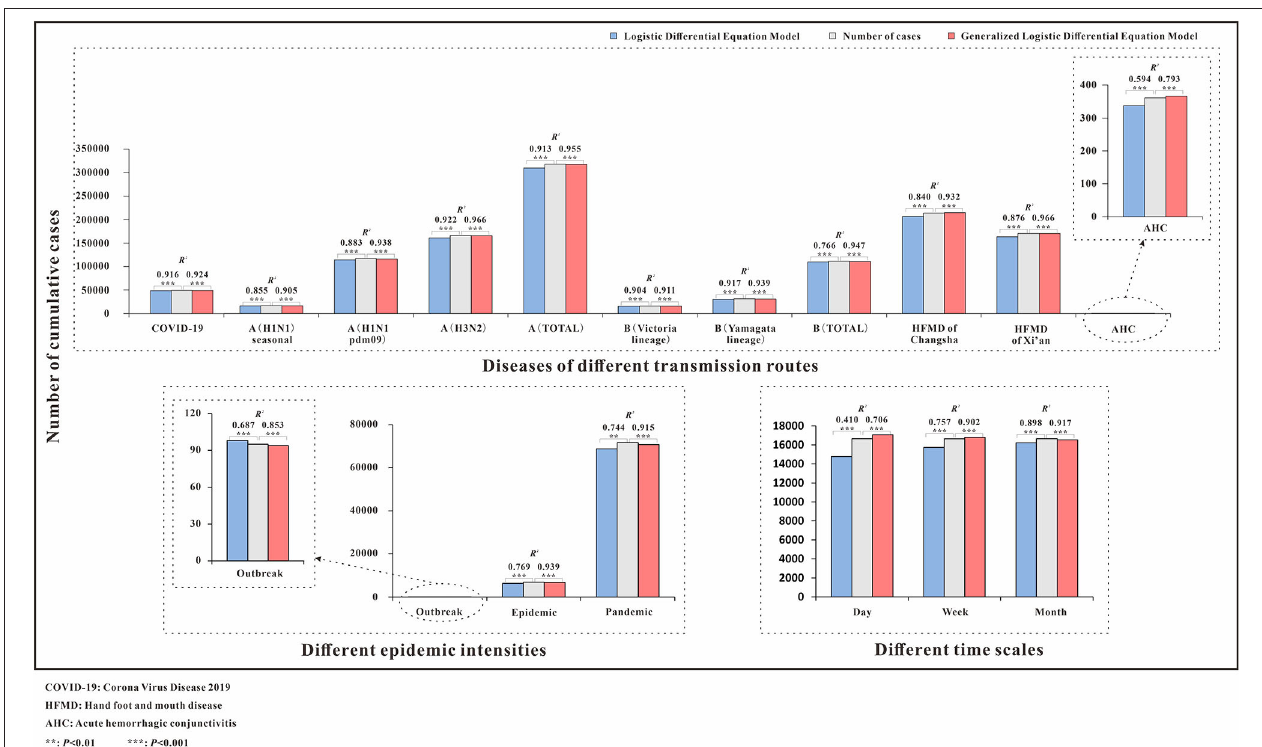
FIGURE 2 | Number of cumulative cases and R 2 of logistic and generalized logistic differential equation models. COVID-19, coronavirus disease 2019; HFMD, hand, foot, and mouth disease; AHC, acute hemorrhagic conjunctivitis; ** p < 0.01; *** p < 0.001.